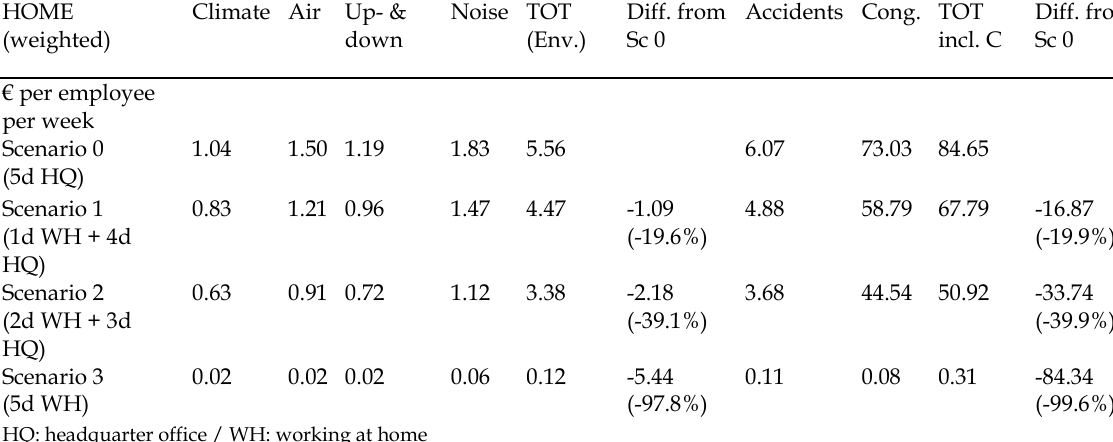
Table 6. Marginal external costs by working at home per employee per week (€ 2011): weighted average of the modal categories (MOBI,